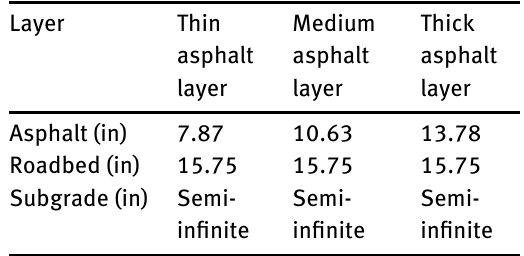
Table 12: Asphaltic overlayment track geometry and layer thickness.